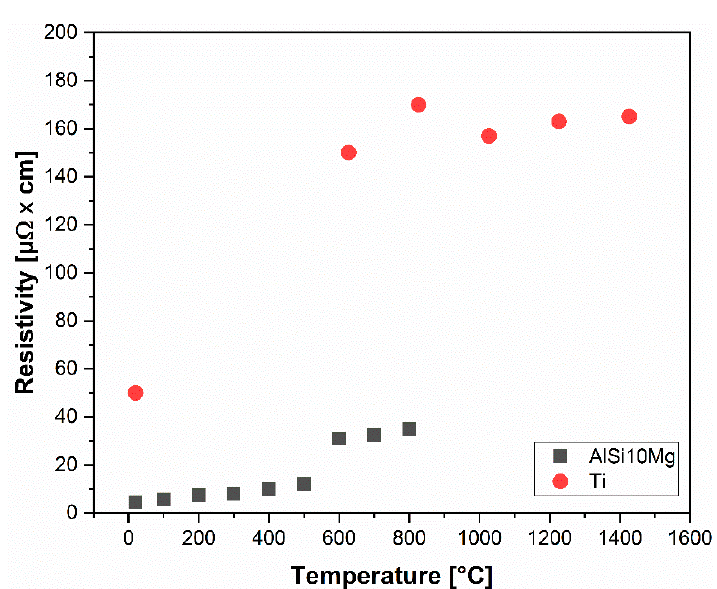
Figure 8. Electrical resistivity as a function of temperature for AlSi10Mg [29] and Ti [30]. Data in the graph were multiplied by 10 8 .